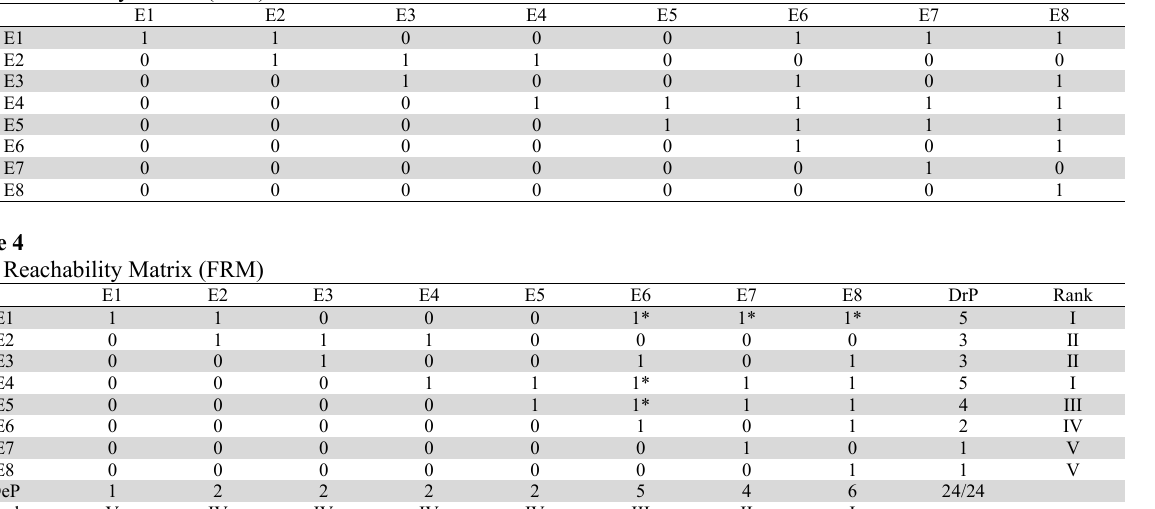
Initial Reachability Matrix (IRM)